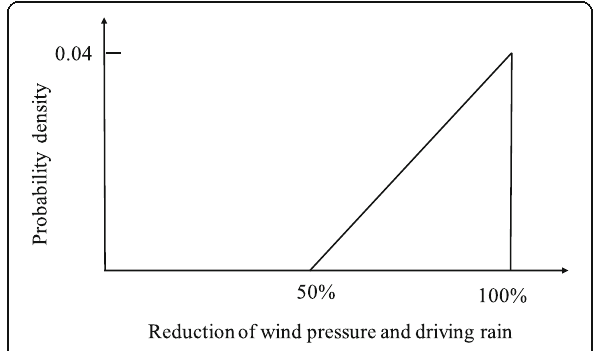
Fig. 9 Reduction of wind pressure and wind-driven rain on windward windows due to shutters